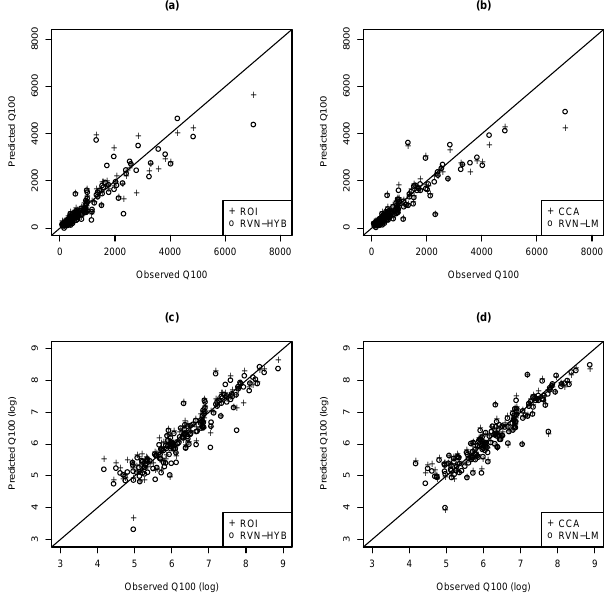
Figure 9. Quantile–quantile plot of Q100 for the RVN method with the regression-based